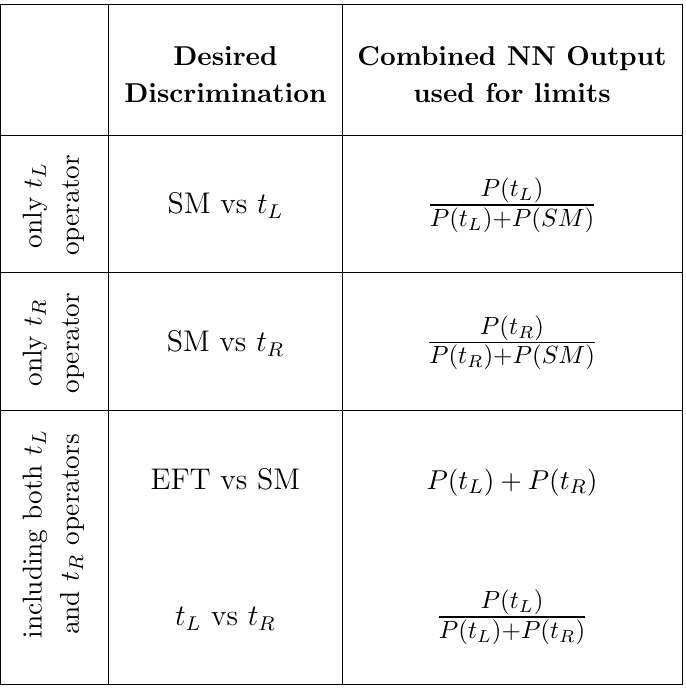
Table 2 . De(cid:12)nitions of the combined NN outputs used for deriving limits in di(cid:11)erent